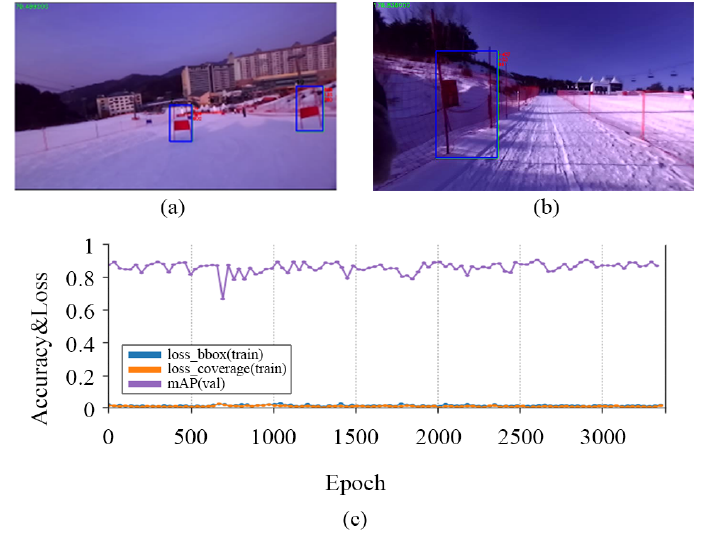
Figure 6. The correct result of recognition ( a ), the incorrect result of recognition ( b ) and the result graph of training ( c